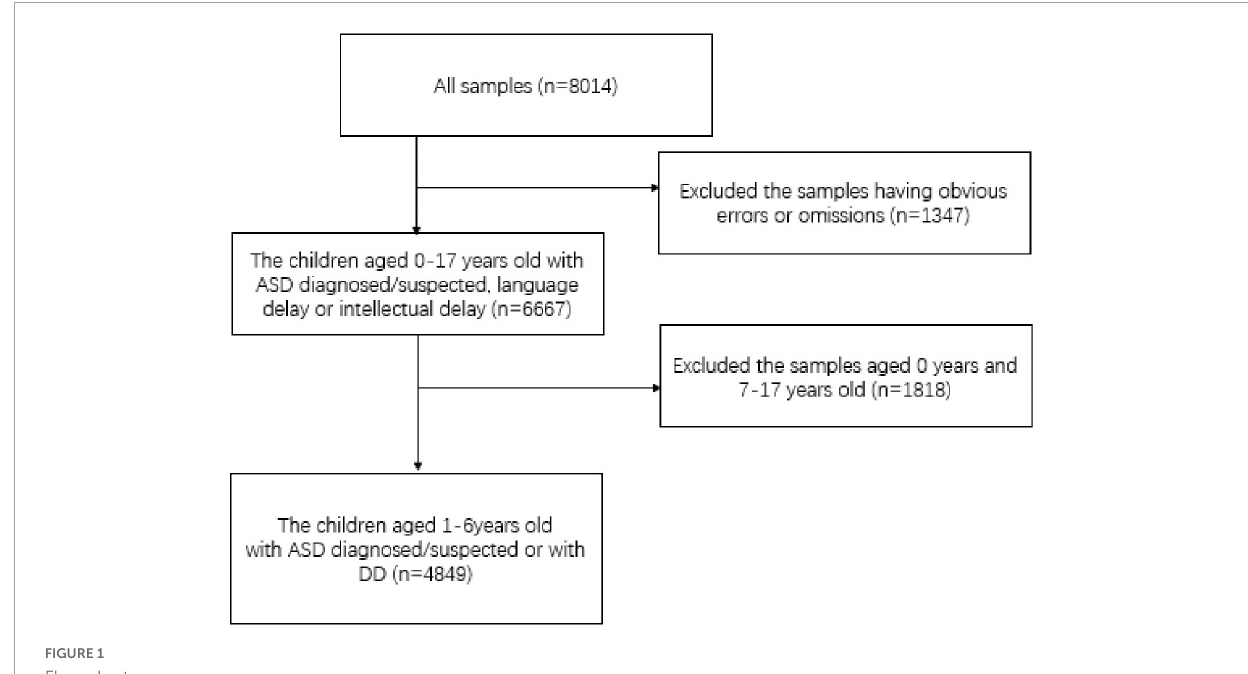
FIGURE1 Flow chart.